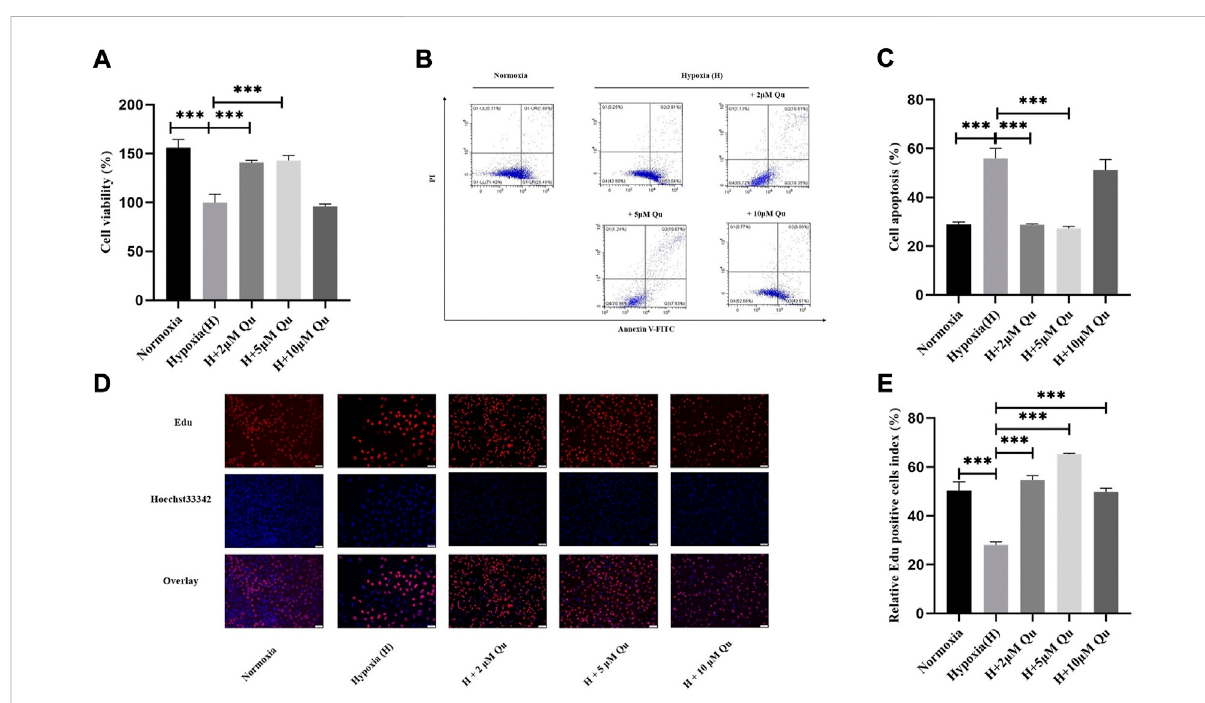
FIGURE 5 Quercetinimprovedbiologicalfunctionoftrophoblastsunderhypoxiacondition. (A) Cellviabilityoftrophoblasts. (B) Flowchartoftrophoblasts apoptosis. (C) Quantitative analysis of trophoblasts apoptosis. (D) Fluorescence images of trophoblasts proliferation. Upper row, EdU fl uorescent signals (red); Middle row, Hoechst 33342 fl uorescent signals (blue); Lower row, overlapped fl uorescent signals. Scale bar: 50 μ m. (E) Quantitative analysis of trophoblasts proliferation. n = 3, *** p < 0.001. Abbreviation: H, hypoxia; Qu,